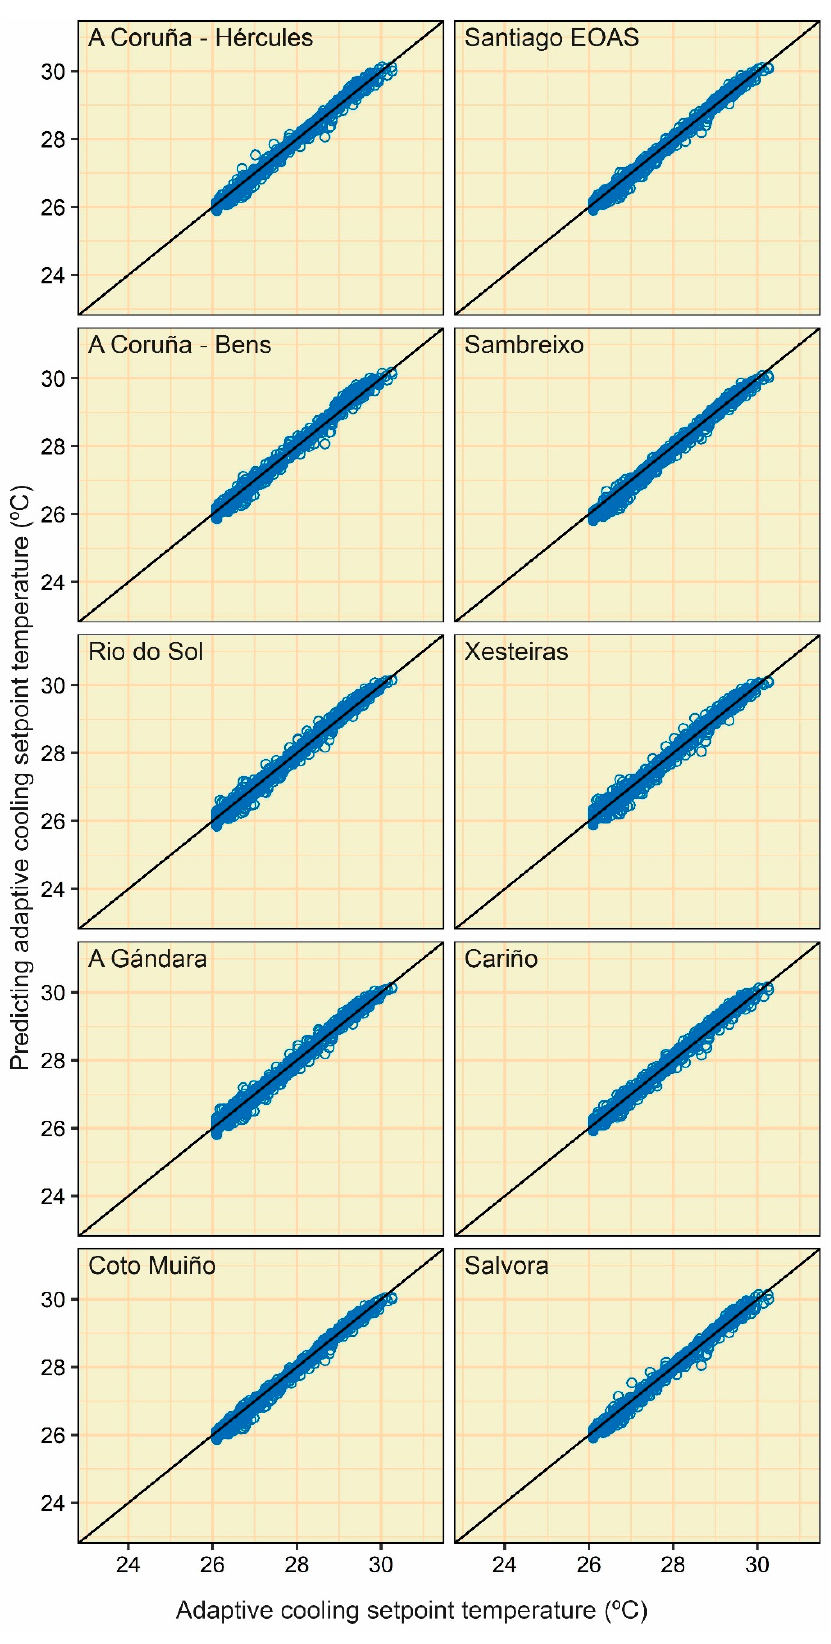
Figure A6. Point clouds between the actual and predicting adaptive cooling setpoint temperature values (category III) of the MLP (approach 1).